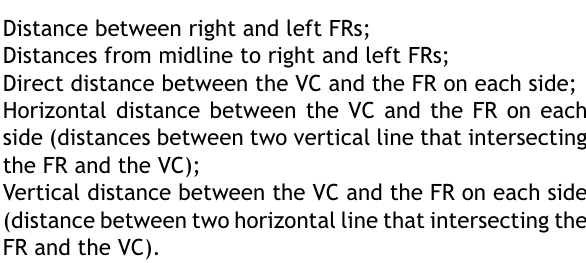
Measurement indexes of the study. A, Imaginary midline vertical to the rostrum; B (1), distance between right FR to midline; B (2), distance between left FR to midline; C, imag- inary horizontal line connecting the VCs; D, imaginary vertical line passing the VC; E, imaginary line connecting FR to VC; F, the rotundum angle with the vertical line; G, H and I, horizontal, vertical and direct distances between FR and VC, respectively (R, right). Right and left rotundum angles (calculated as the angle between the imaginary line connecting FR to VC and verti- cal line passing the